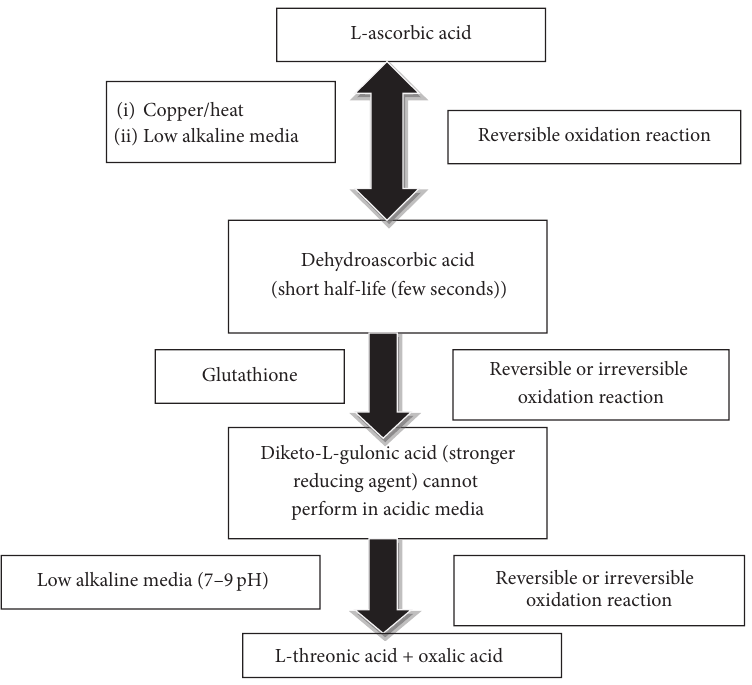
Figure 1: Scheme of the biological function of ascorbic acid as an